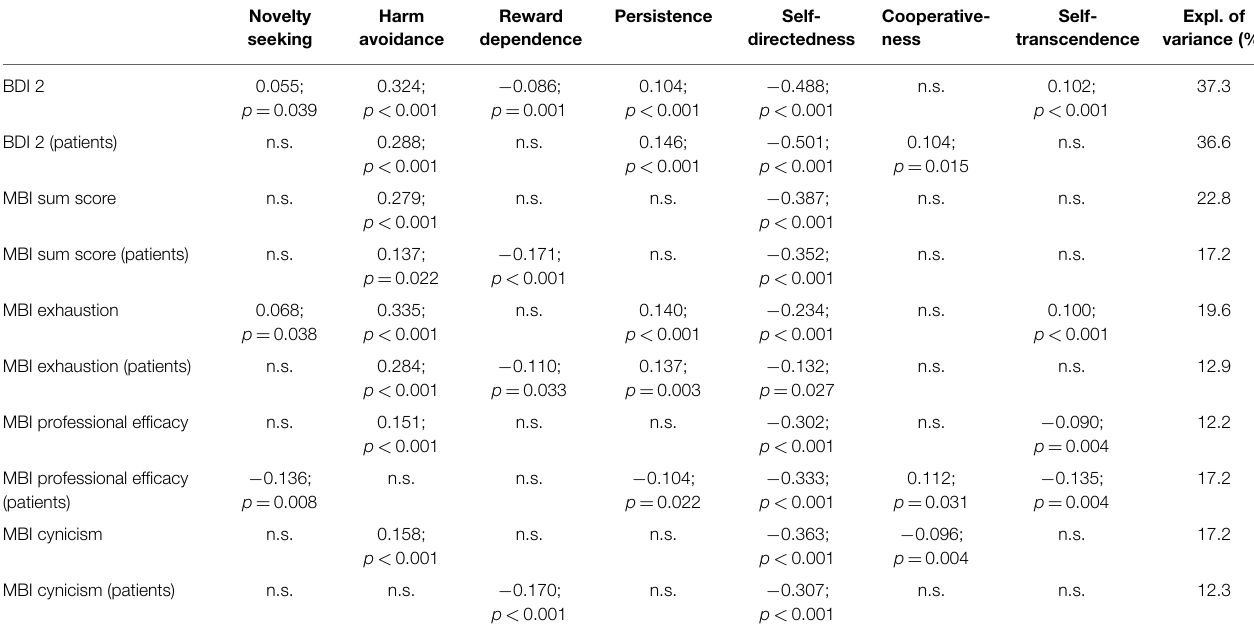
TABLE 3 | Estimated standardized regression weights between the seven TCI dimensions and burnout/depression in the unrestricted model .